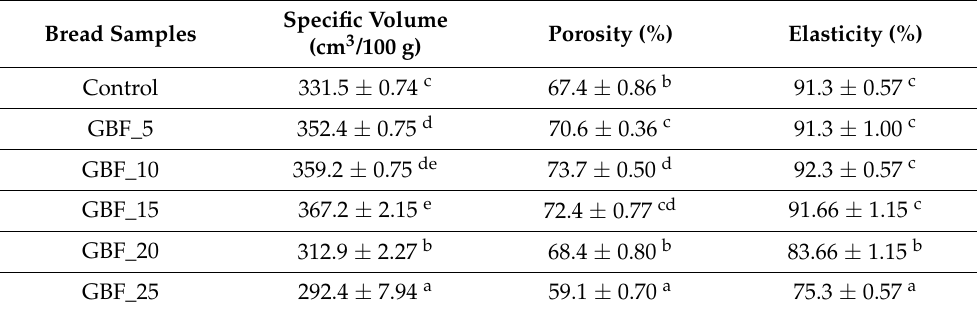
Table 4. Physical characteristics of the bread samples with different levels of germinated bean flour (GBF) additions.